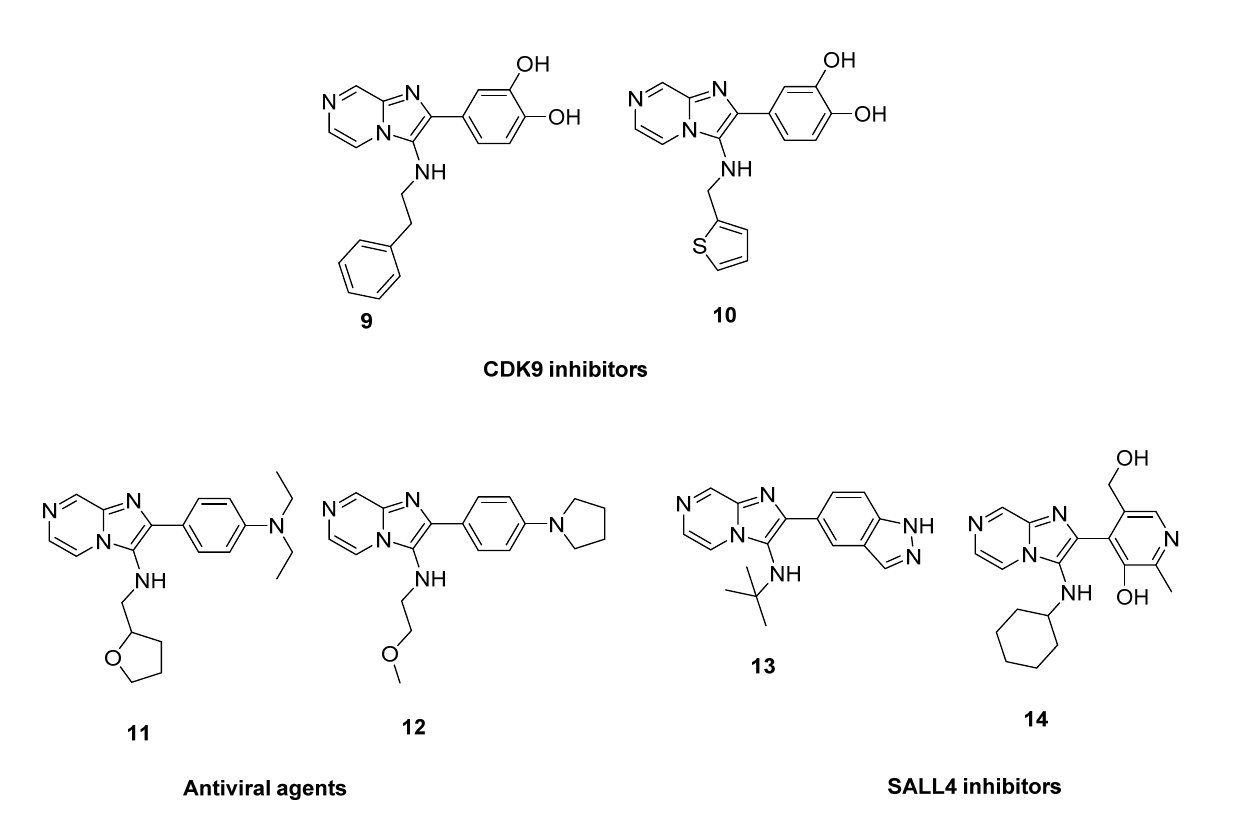
Figure 2. 2-Phenylimidazo[1,2- a ]pyrazin-3-amines reported in the literature.